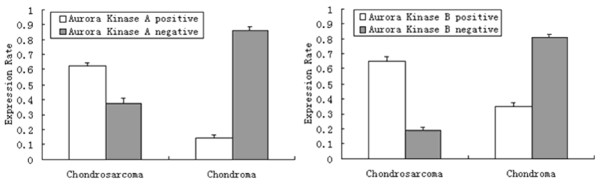
Comparison of the expression rate of Aurora Kinase A and B in chondrosarcoma and chondroma.